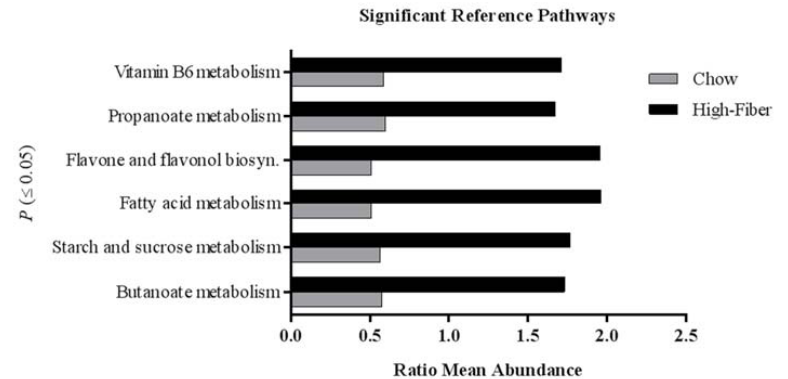
Figure 5. Functional predictions for fecal microbiomes of TS4/APC high fiber-fed and chow-fed mice. Significantly different KEGG (Kyoto Encyclopedia of Genes and Genomes) pathways ( p < 0.05) with a greater ratio mean abundance in TS4/APC high fiber-fed mice relative to chow-fed mice, as inferred using PICRUSt (Phylogenetic Investigation of Communities by Reconstruction of Unobserved States) analysis of fecal microbiomes.